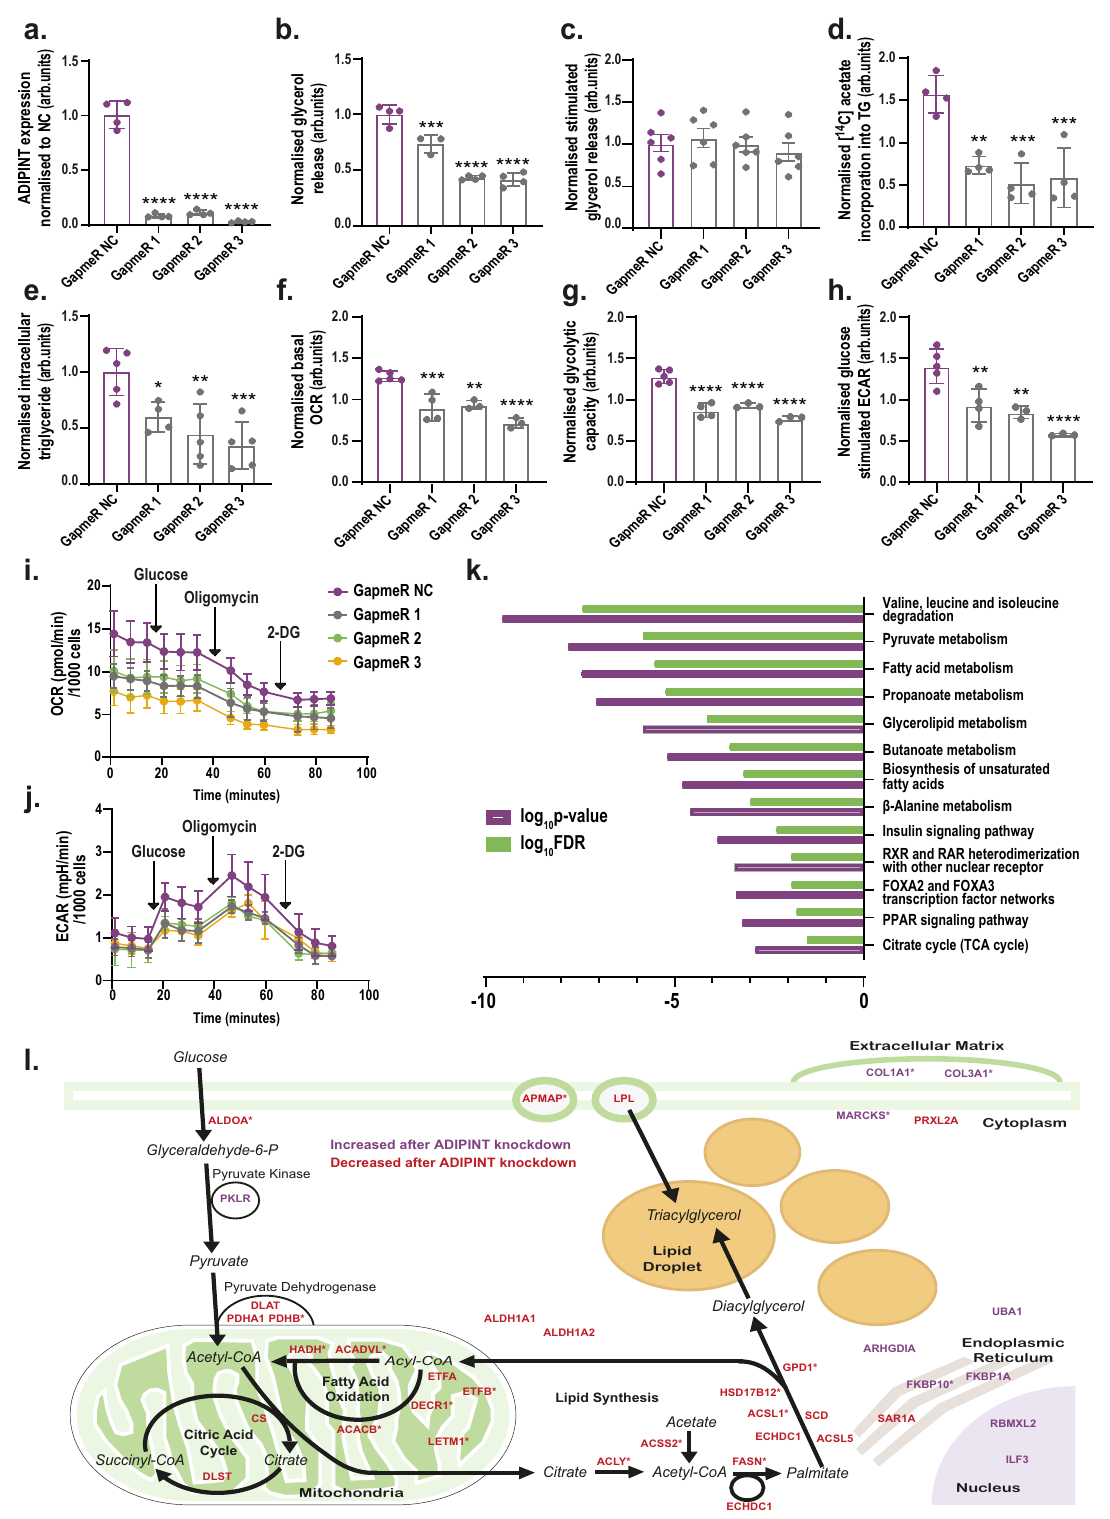
accompanied by reduced levels of intracellular oxaloacetate (Fig. 4d); intracellular pyruvate levels were unaffected (Fig. 4e). Thus, lower oxaloacetate concentration was not the result of lower pyruvate concentration. As PC produces oxaloacetate in the mitochondrial matrix we determined if the changes in oxaloacetate vious data, western blots of whole-cell lysates revealed that the total